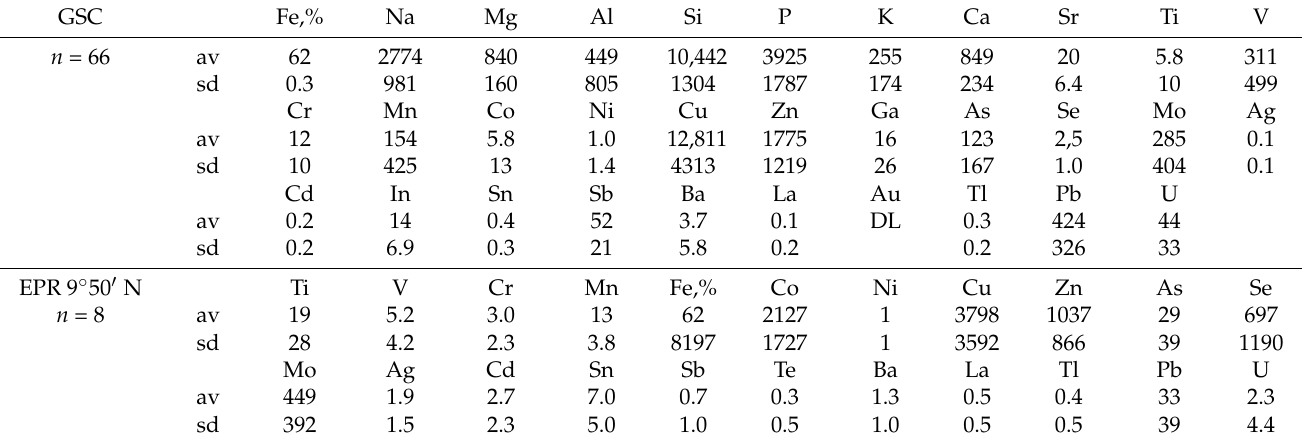
Table 7. Average contents (av) and standard deviations (sd) of TEs in IOHs of the